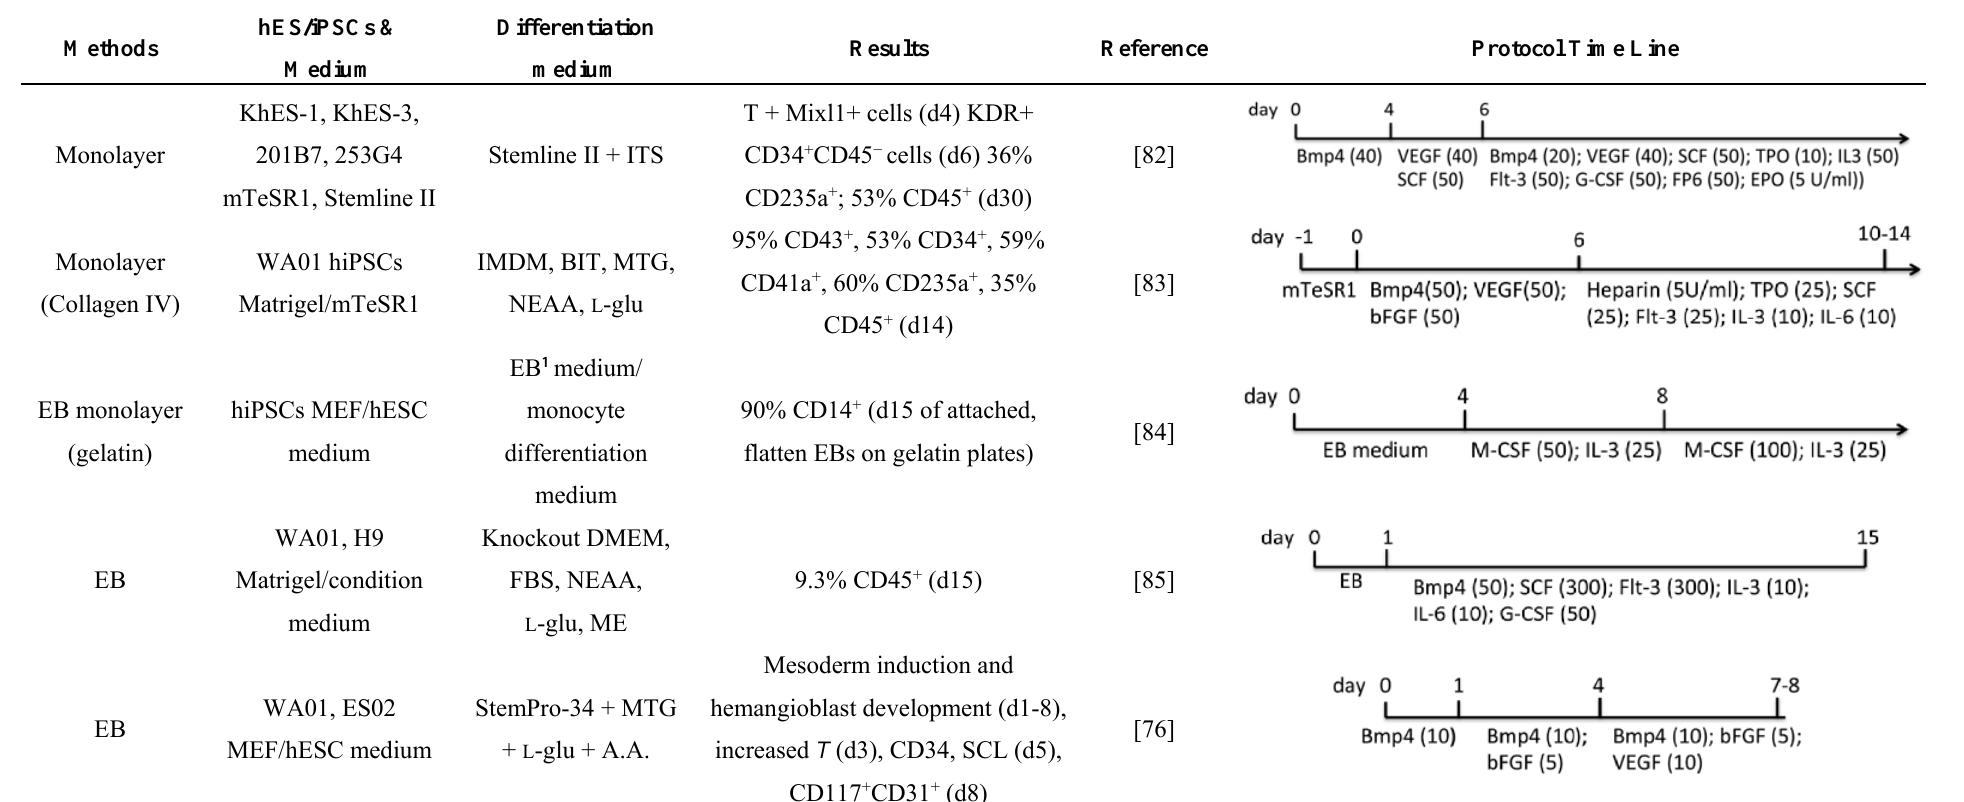
Table 4. Protocols for hematopoietic differentiation from